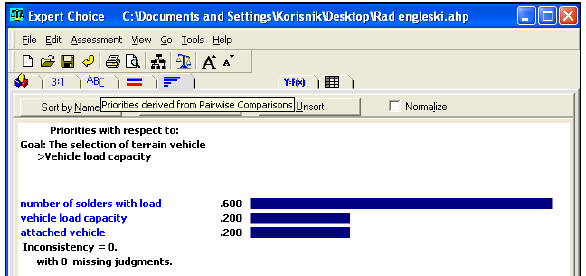
Figure 11. Guarantee